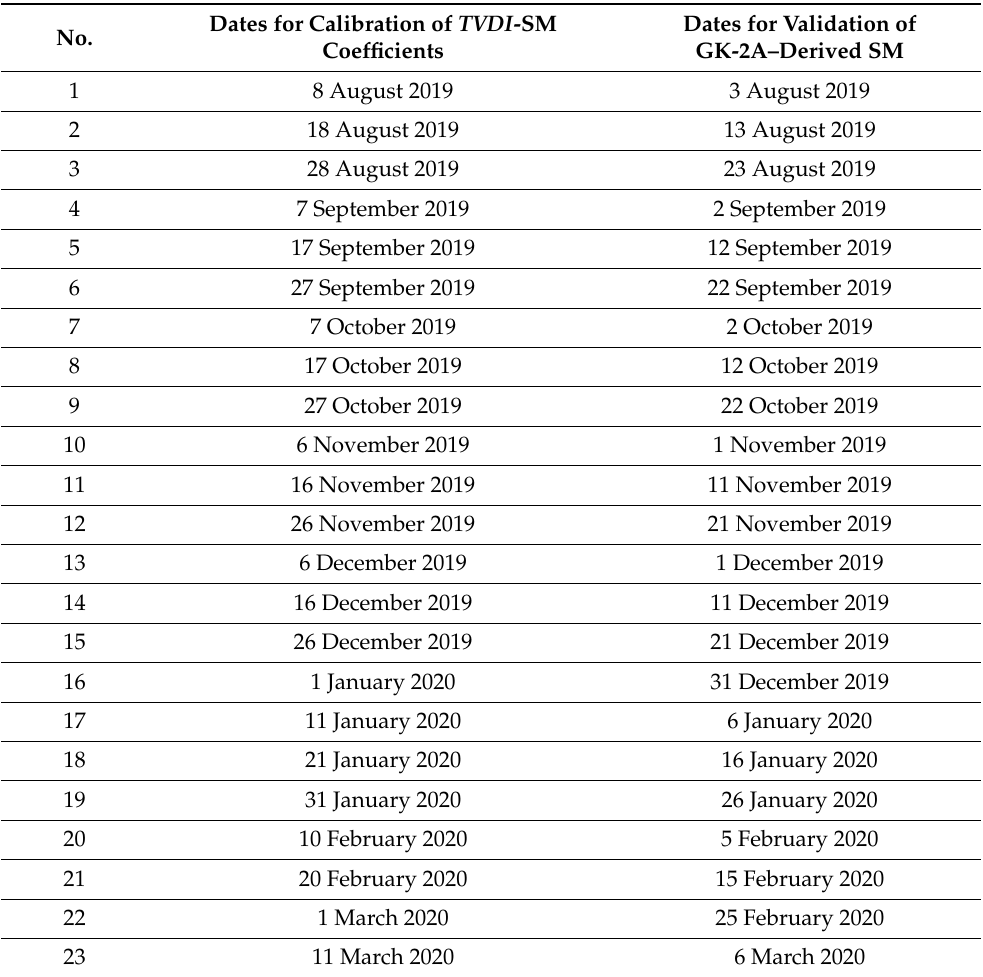
Dates for Validation